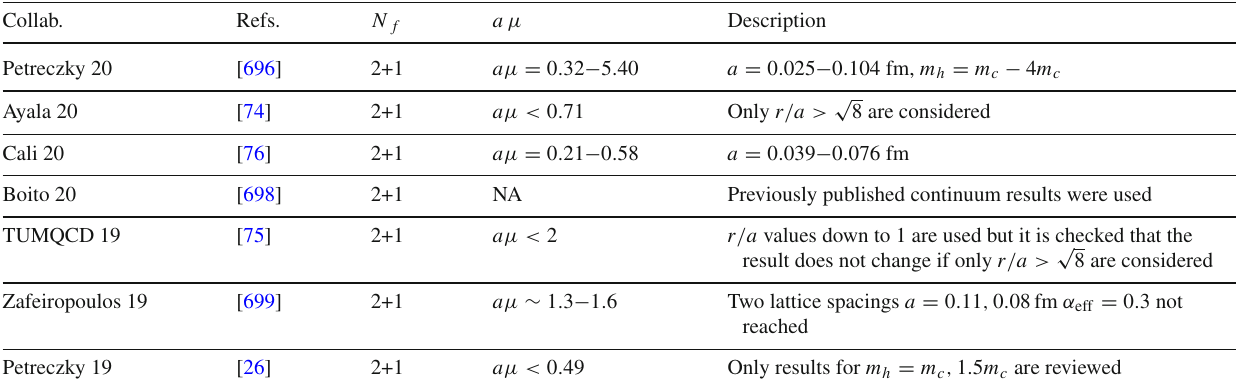
Table 173 Continuum limit for α s determinations with N f = 3